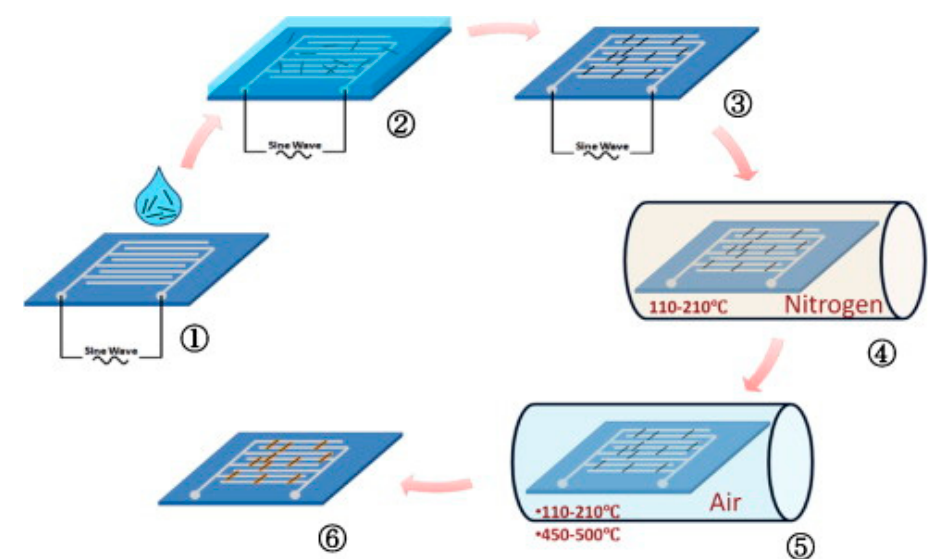
Figure 11. Schematic diagram of nanowire integration: (1) nanowire drop-casting; (2) DEP device connection; (3) nanowire row; (4) nanowire bonding; (5) sensor oxidation; (6) obtaining the final sensor [71].